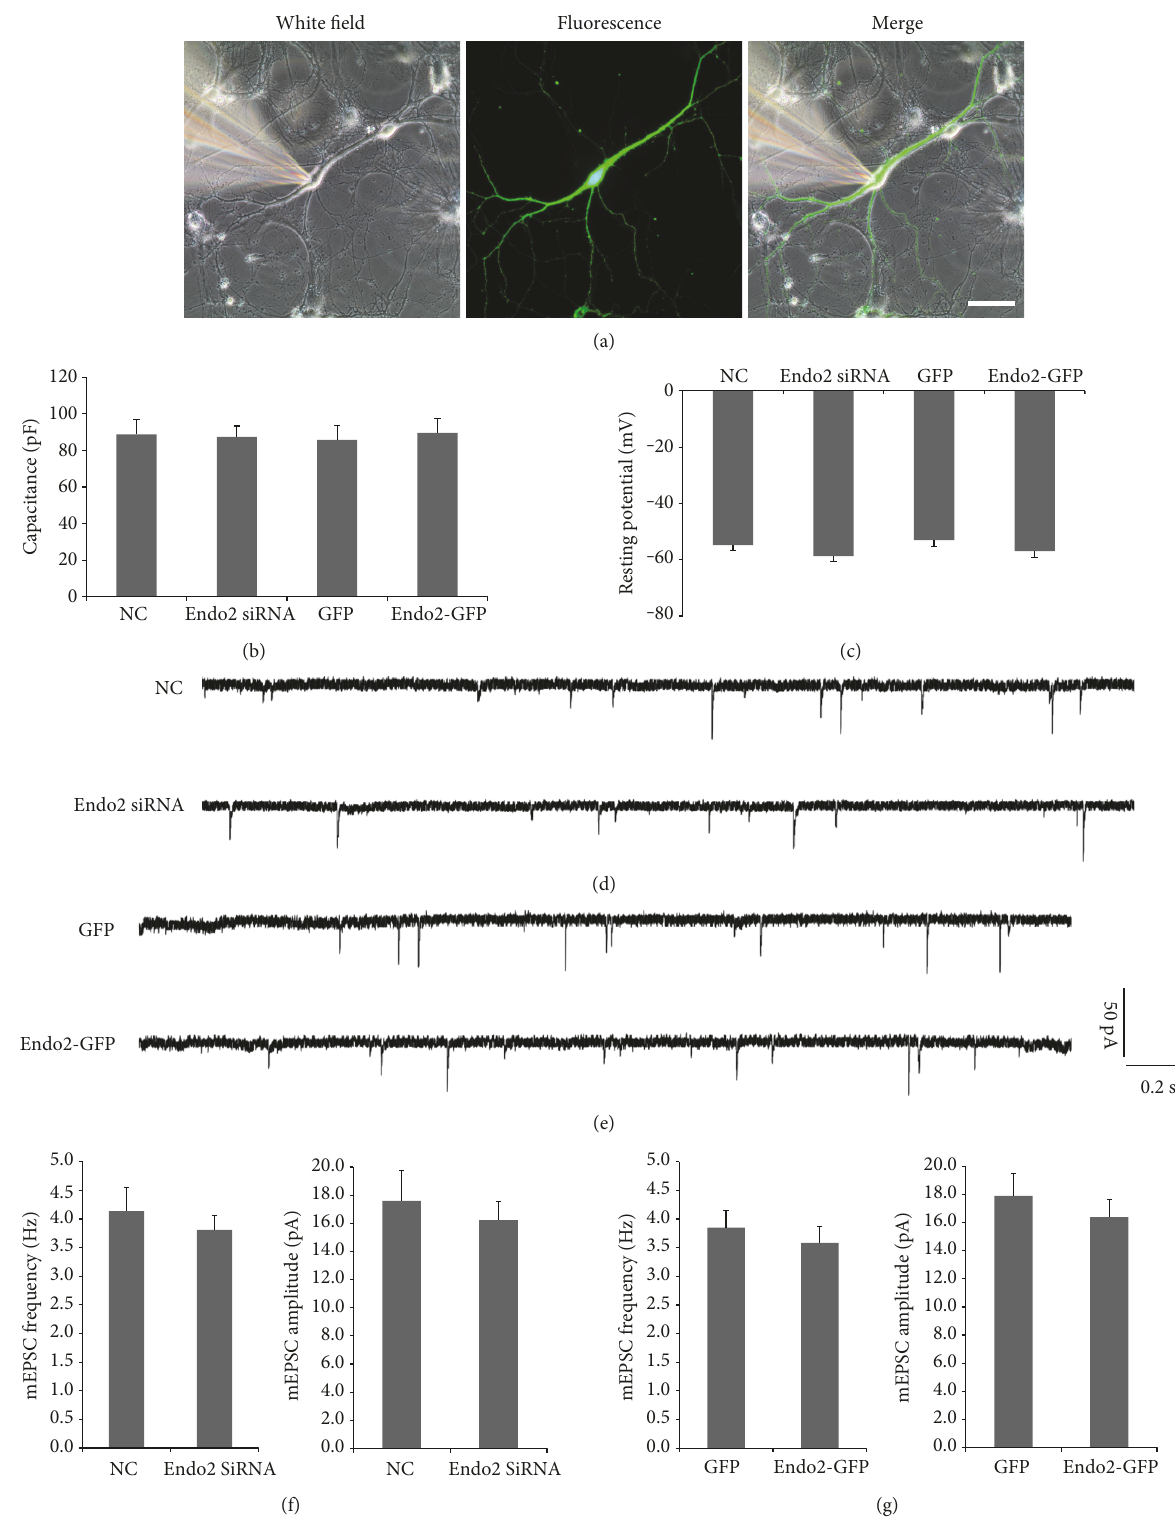
Figure 1: The electrophysiology of neurons with endophilin2 knockdown or overexpression. (a) Image of a neuron obtained from patch recording. Scale bar, 50 μ m. (b-c) Bar plots of the mean values of resting membrane potentials and capacitance of patched neurons in the four groups. (d-e) mEPSC tracings are shown in neurons transfected with NC, Endo2 siRNA, GFP, and Endo2-GFP. (f) Histogram plots of mEPSC frequency and amplitude in neurons transfected with NC and Endo2 siRNA. n = 16 cells, 3 cultures from 6 SD rats. (g) Histogram plots of mEPSC frequency and amplitude in neurons transfected with GFP and Endo2-GFP. n = 16 cells, 3 cultures from 6 SD